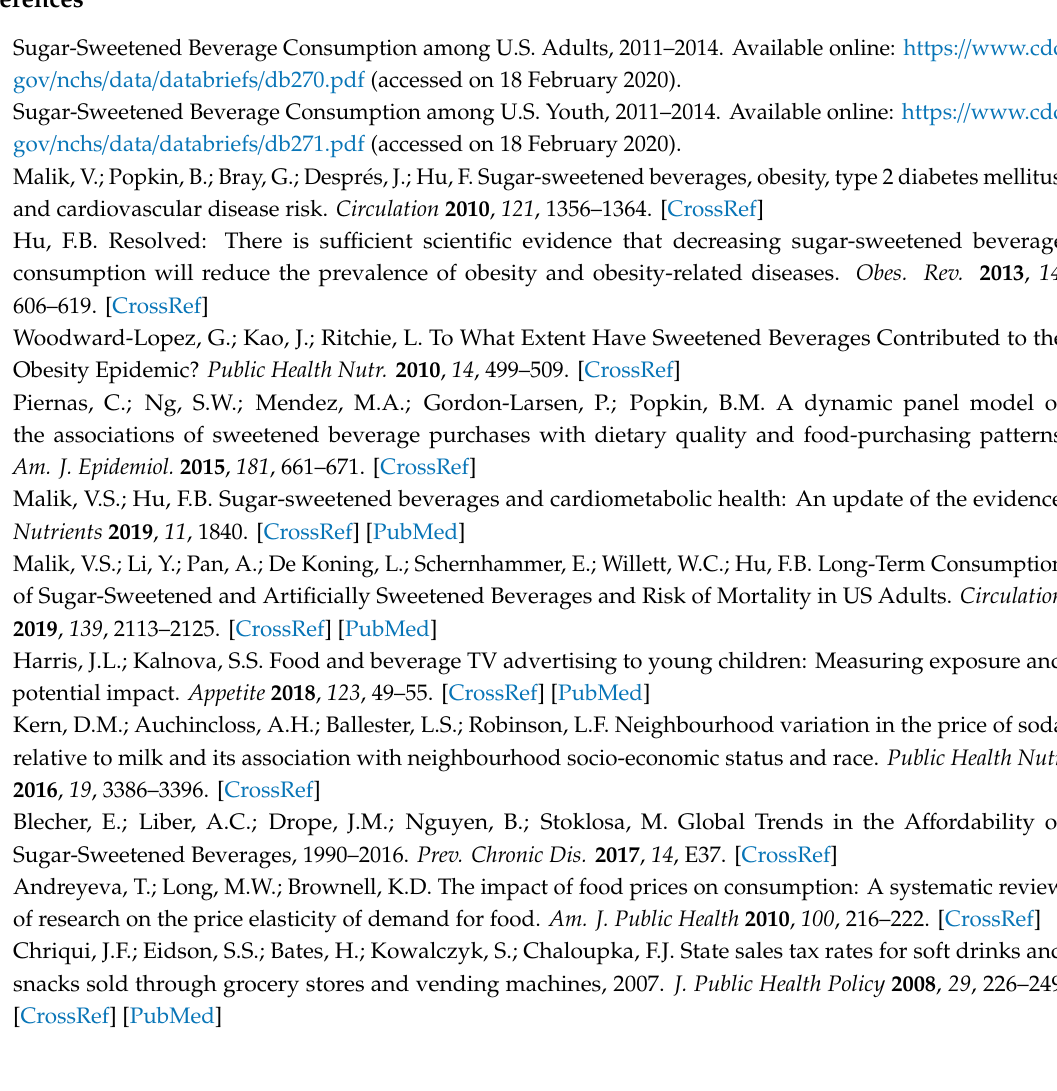
Figure S1: Sample selection flow chart; Figure S2: Power analysis for sugar-sweetened beverage consumption; Figure S3: Sensitivity analysis. Di ff erence-in-di ff erences analysis adjusted for covariates; Table S1: Number (%) of survey participants by time interval during follow-up survey; Table S2: Baseline characteristics of participants retained in the analytic sample and dropped out due to loss-to-follow-up; Table S3: Description of the di ff erence-in-di ff erences models. Table S4: Daily consumption of bottled water, sugar-sweetened and diet beverage during baseline and follow-up; Table S5: Within-person change in daily consumption of bottled water, sugar-sweetened and diet beverage during baseline and follow-up; Table S6: Di ff erence-in-di ff erences analysis (adjusted for covariates1): relative risk of being in the specified category 12 months after the tax in Philadelphia relative to that of the comparison